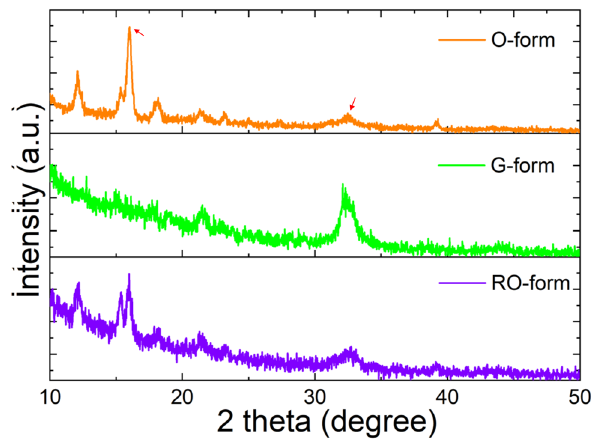
Figure 5. X-ray diffraction (XRD) patterns of DSP crystals in O-, G- and RO-forms.